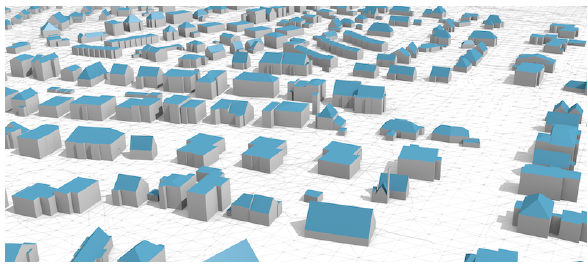
Figure 1. Semantic CityGML LoD2 model of